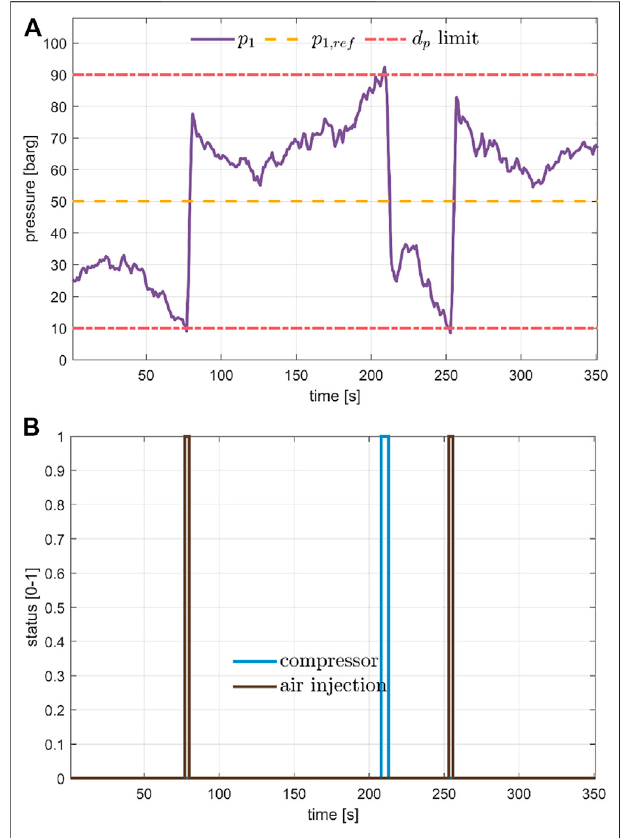
FIGURE 5 | Pressure control keeping the pressure upstream blower 1 insidethedesignconstraint, plot (A) by switching ONand OFFthe airinjection and the compressor for air removal, shown in plot (B)